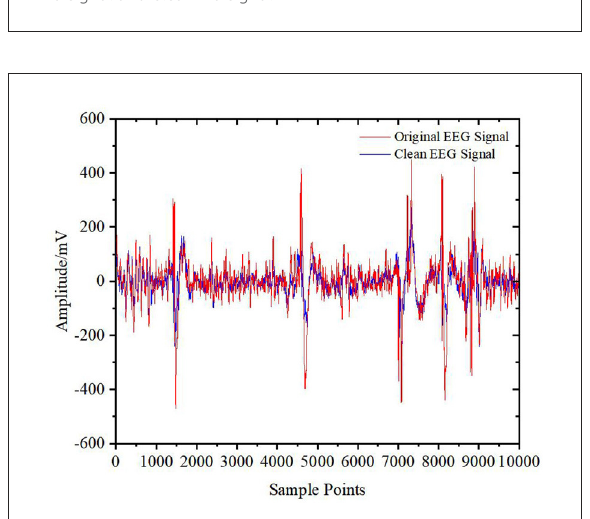
FIGURE10 Original signal and clean signal.